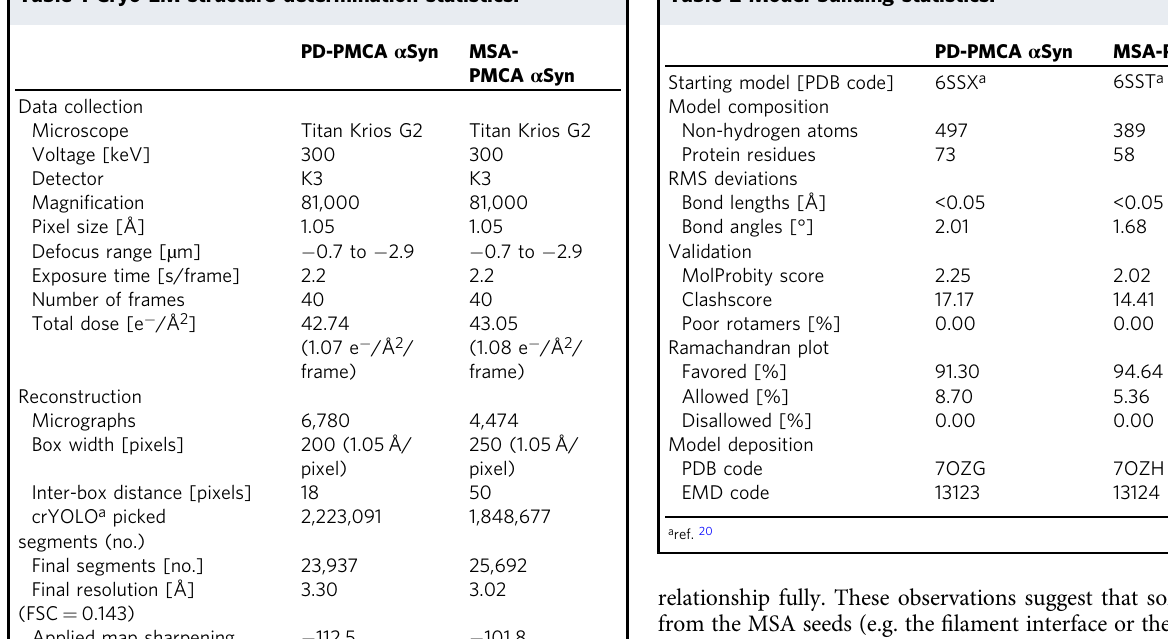
Fig. 2 Cryo-EM structures of α Syn PMCA fi brils seeded from brain homogenates. a Cryo-EM structures of PD-PMCA (left) and MSA-PMCA (right) α Syn fi brils. From the outside to the inside, the panels show extracts from representative micrographs, a full cross over (180° turn) of the reconstructed fi bril, with two proto fi laments colored in different shades of blue (PD-PMCA) or green (MSA-PMCA), and semitransparent surfaces overlaid with their atomic models viewed from different angles. Scale bars, 20 nm. b Amino acid sequence of α Syn (from G14 to K96; based on UniProt: P37840) with a schematic depiction of the secondary structure of the proto fi lament fold. β -strands are shown as arrows and numbered from β 1 to β 8 (for PD) or β 7 (for MSA), respectively. The region from V26 to E35 was not resolved (indicated by a dashed line). c Top view onto two opposite subunits of the reconstructed PD (left; colored in shades of blue) and MSA (right; colored in shades of green). One proto fi lament is shown as a mesh-stick model, the other schematically depicted by its secondary structure matching the assignment in b . d Close-up view of the proto fi lament interface, with interface amino acids shown as stick models. e The calculated electrostatic potential was mapped onto the surface of one proto fi lament and colored according to the color scale on the left. The central subunits of the other proto fi lament are shown as cartoon model. Cross-sections are shown as a surface-cartoon model with amino acids forming the central negatively charged cavity in PD-PMCA α Syn (from K45 to E57) labeled explicitly.